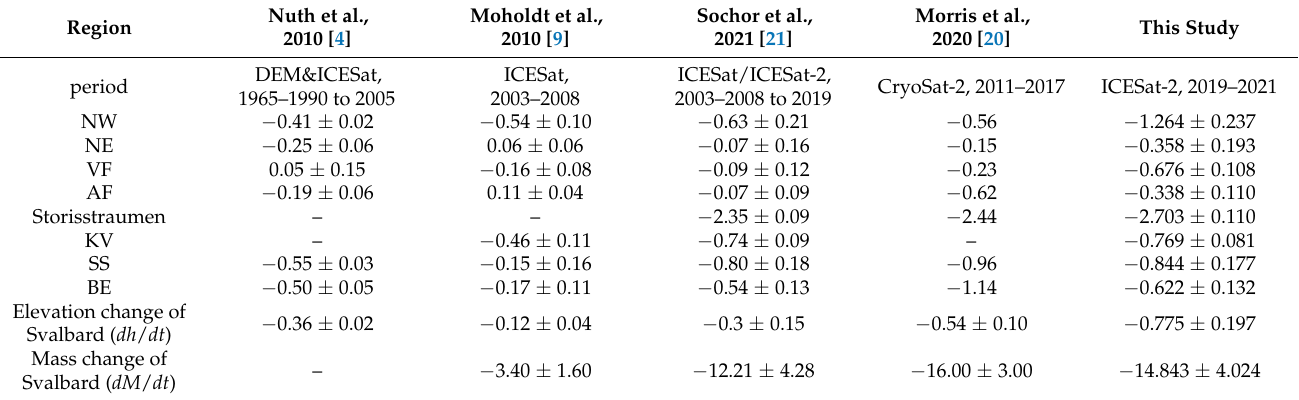
Table 3. Temporal elevation change of Svalbard and subregions and mass change for Svalbard, all elevation change values are in m yr − 1 , and mass change values are in Gt yr − 1